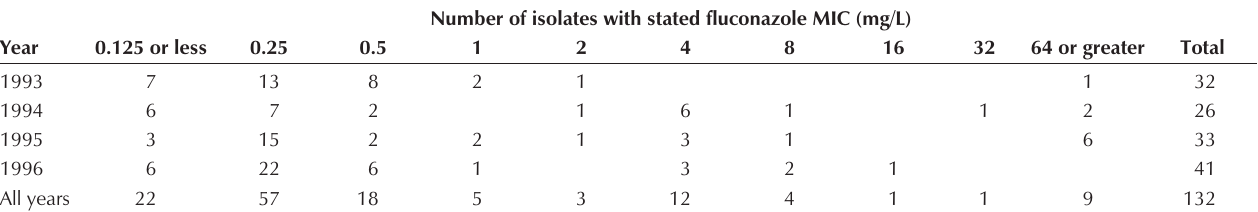
Distribution of fluconazole minimum inhibitory concentrations (MICs) by year for all yeast species tested Number of isolates with stated fluconazole MIC (mg/L)